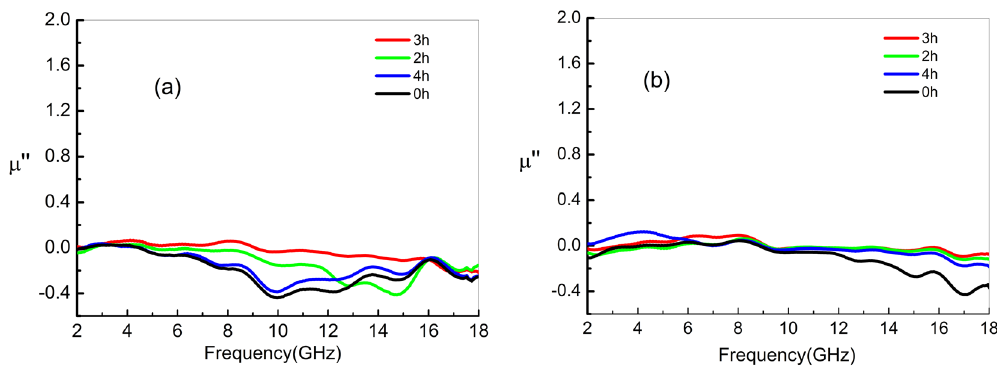
Figure 7. Imaginary part ( μ″ ) of the complex permeability of the CNT composites heat-treated for 2, 3, and 4 h at temperatures of 700 °C and 900 °C; μ″ of the untreated composites is denoted as 0 h.